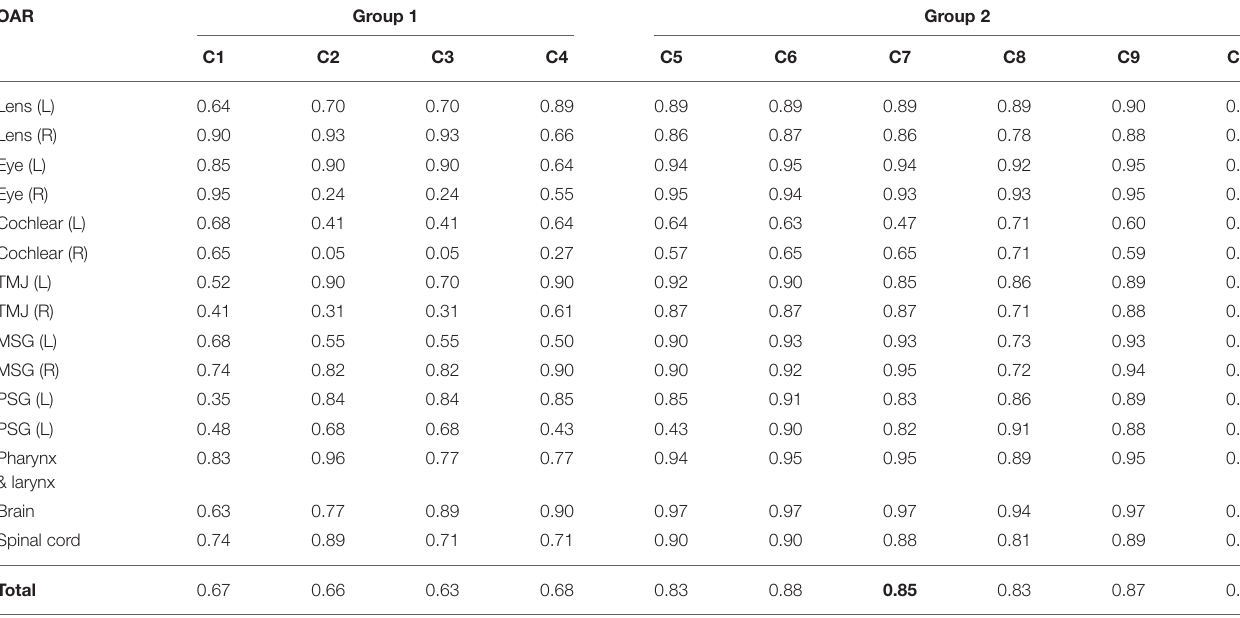
TABLE 3 | Dice similarity coefficient of each clinical test set obtained from deep-learning-based automatic segmentation. OAR